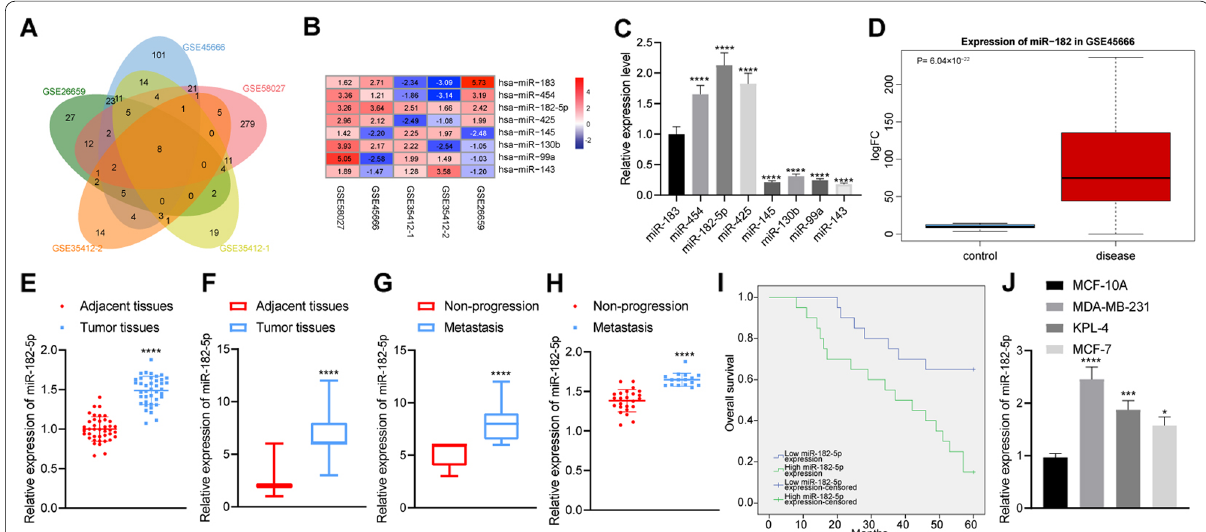
Fig. 1 Upregulated expression of miR-182-5p in breast cancer tissues and cells. A Venn diagram of the identified differential miRNAs in breast cancer-related datasets GSE26659, GSE35412-1, GSE35412-2, GSE45666 and GSE58027; B A heat map of 8 intersected miRNA expression in breast cancer-related datasets GSE26659, GSE35412-1, GSE35412-2, GSE45666 and GSE58027 (the right shows the color scale of log2FC value); C Expression of 8 intersected miRNAs (miR-183, miR-454, miR-425, miR-145, miR-130b, miR-99a, miR-143, miR-182-5p) in MDA-MB-231 cells detected by RT-qPCR, the statistical power was 1; D A box plot of miR-182-5p expression in breast cancer tissue and adjacent normal tissue in the dataset GSE45666 (the left blue box represents the expression of adjacent normal tissue samples, and the right red box represents the expression of breast cancer tissue samples); E Expression of miR-182-5p in cancer tissues and adjacent normal tissues of 40 breast cancer patients detected by RT-qPCR, the statistical power was 1; F Expression of miR-182-5p in breast cancer tissues and adjacent normal tissues detected by ISH, the statistical power was 1; G Expression of miR-182-5p in metastasis tissues of 16 breast cancer patients with distant metastasis and cancer tissue of 24 breast cancer patients without distant metastasis detected by ISH, the statistical power was 1; H Expression of miR-182-5p in metastasis tissues of 16 breast cancer patients with distant metastasis and cancer tissue of 24 breast cancer patients without distant metastasis detected by RT-qPCR, the statistical power was 1; I Correlation between the expression of miR-182-5p and the prognosis of 40 breast cancer patients analyzed by Kaplan–Meier curve analysis; J Expression of miR-182-5p in 4 cell lines (MCF-10A, MCF-7, KPL-4 and MDA-MB-231) detected by RT-qPCR, the statistical power was 1. * p < 0.05, *** p < 0.001, **** p < 0.0001 compared with adjacent normal tissues, breast cancer patients without distant metastasis or MCF-10A cell line.